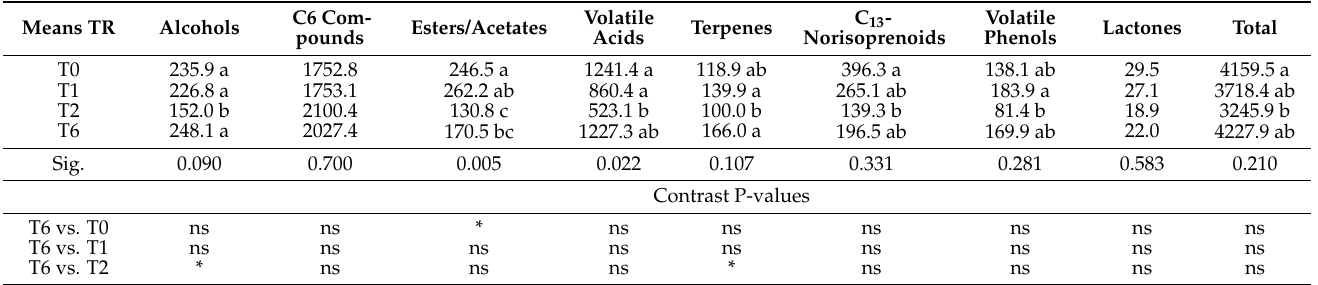
Table 5. Contrast analysis ( p -values < 0.05) by families of compounds in Albariño musts (mean of three